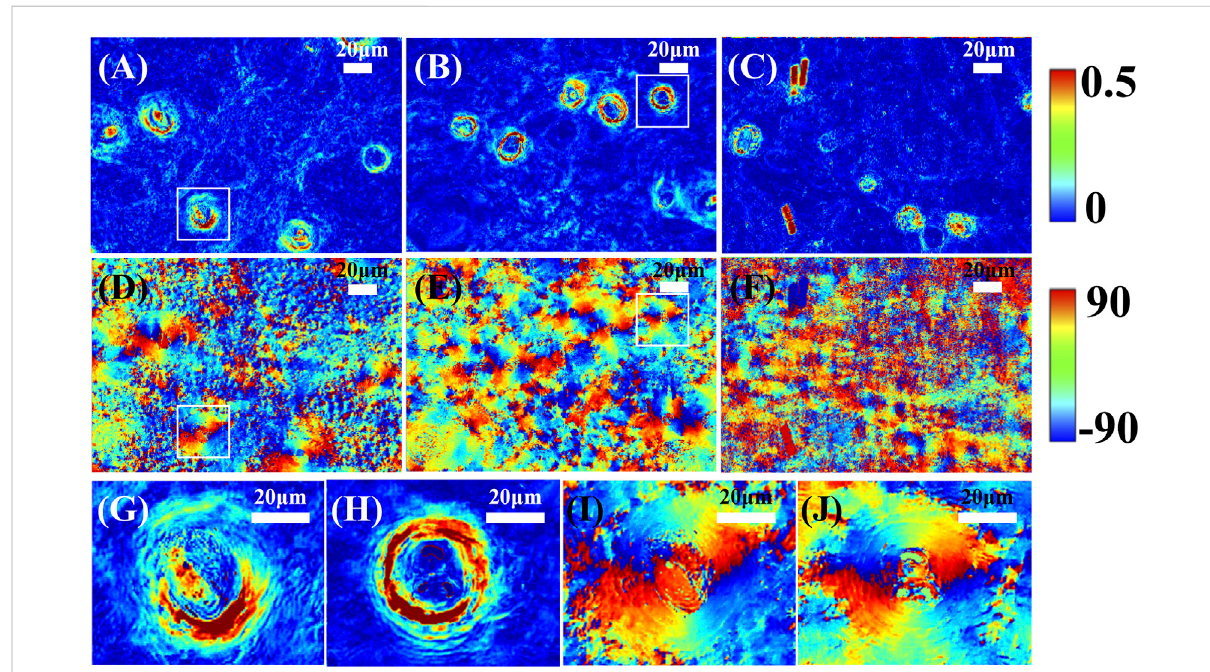
FIGURE 3 MMPD parameter θ and δ imagesofthreemouseskintissue sections. (A – C) aretheparameter δ results. (D – F) are thecorrespondingparameter θ results. (G , H) show the zoom-in images of parameters δ , and (I , J) show the zoom-in images of parameter θ of two selected hair follicle regions marked by the white squares in (A,B) , respectively. All the scale bars in sub fi gures represent 20 μ m